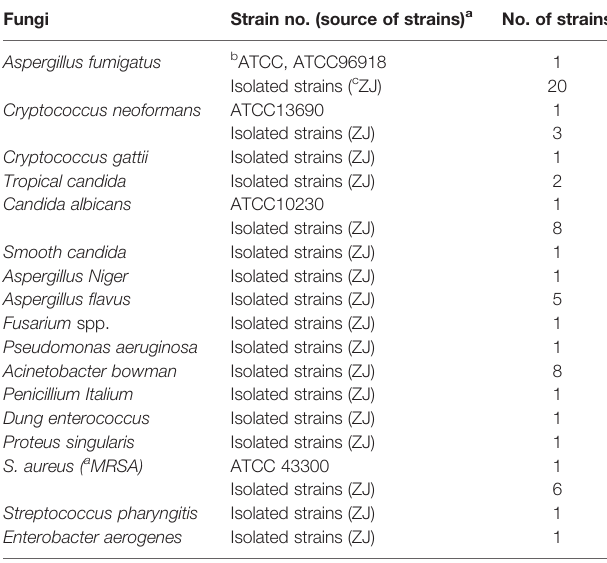
TABLE 1 | Fungi and bacterial strains used in the current